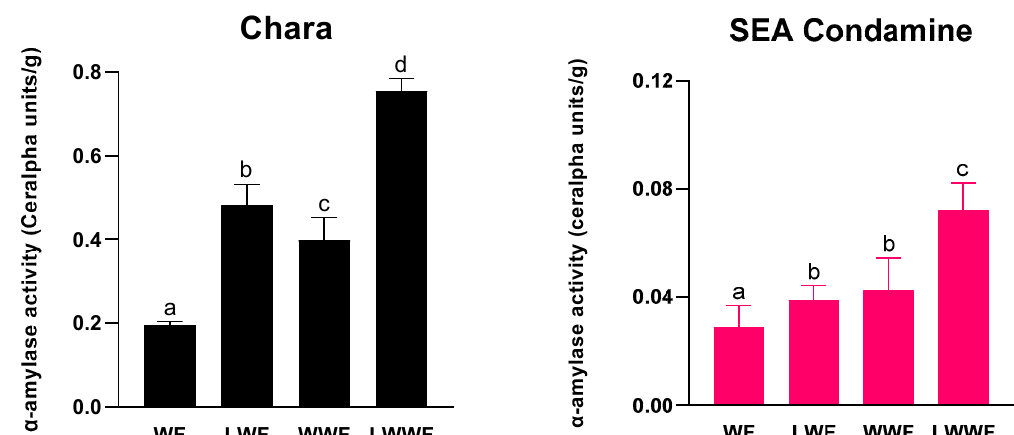
Figure 2. Total α -amylase activity of white and whole-wheat flours milled from wheat grown under different condition during late post-anthesis stage. (WF) control white flour; (LWF) LMA-affected white flour; (WWF) control whole-wheat flour; (LWWF) LMA-affected whole-wheat flour. Respective cultivars marked by different letters indicate significant differences ( p ≤ 0.05).